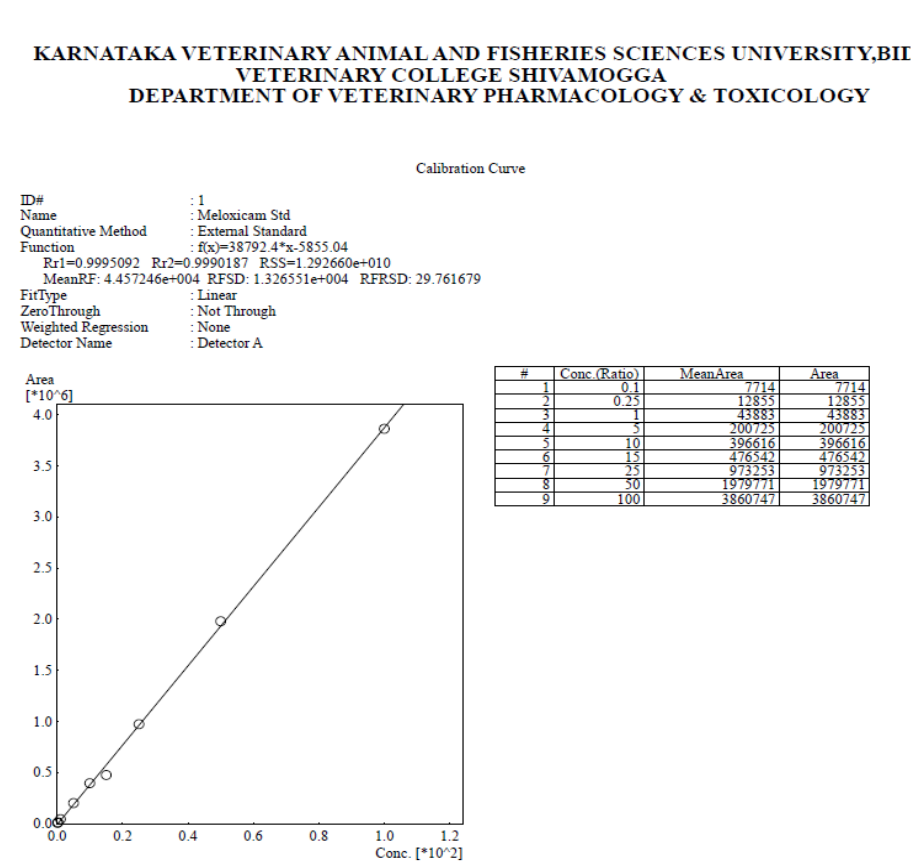
Figure 9. The calibration curve of meloxicam as assessed by HPLC. #—Serial number.